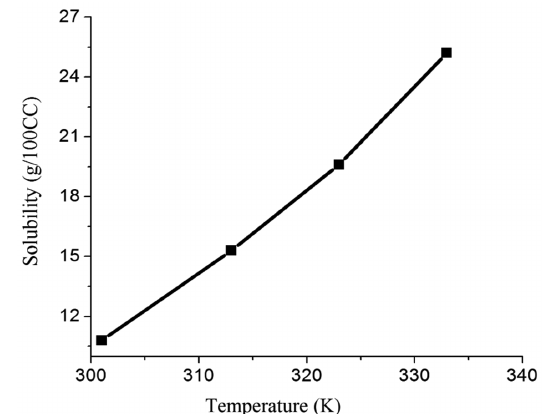
Figure 2. Solubility curve of LCHB crystal.